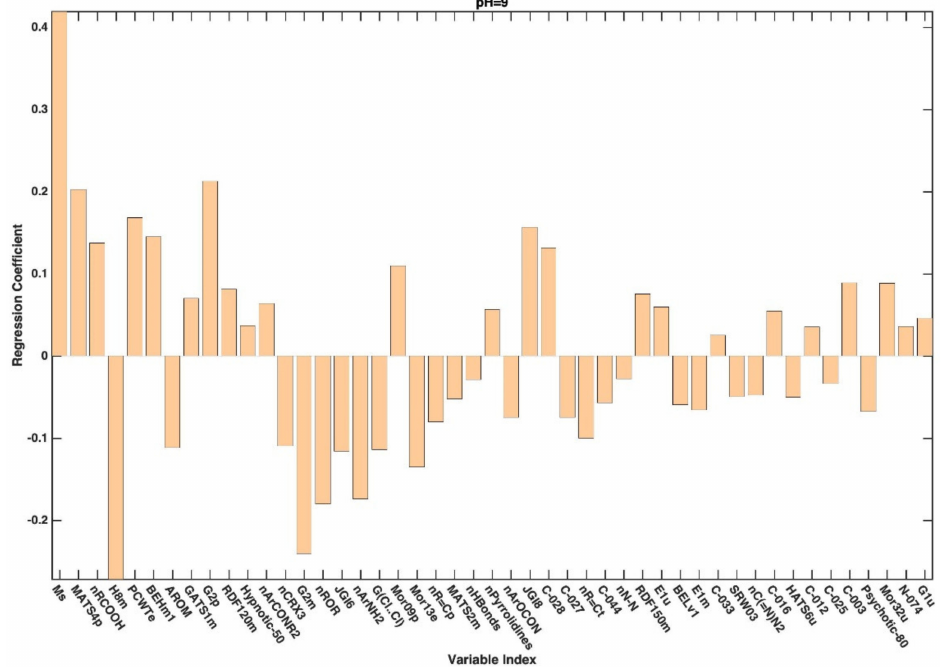
Figure A4. Regression coefficients associated to the descriptors selected by CovSel for the PLS-DA model based on the reduced dataset collected at pH